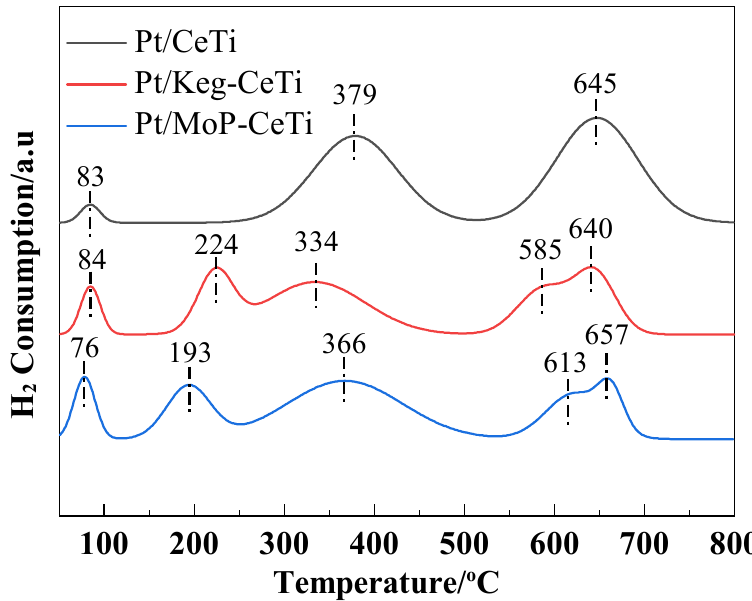
Figure 9. H 2 -TPR profiles of the Pt/CeTi, Pt/Keg-CeTi, and Pt/MoP-CeTi catalysts.